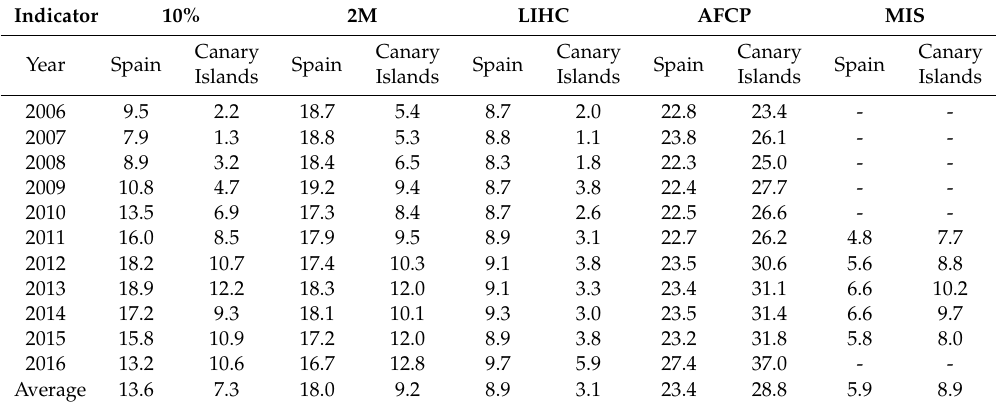
Table 4. Energy poverty indicators Spain–Canary Islands (%).